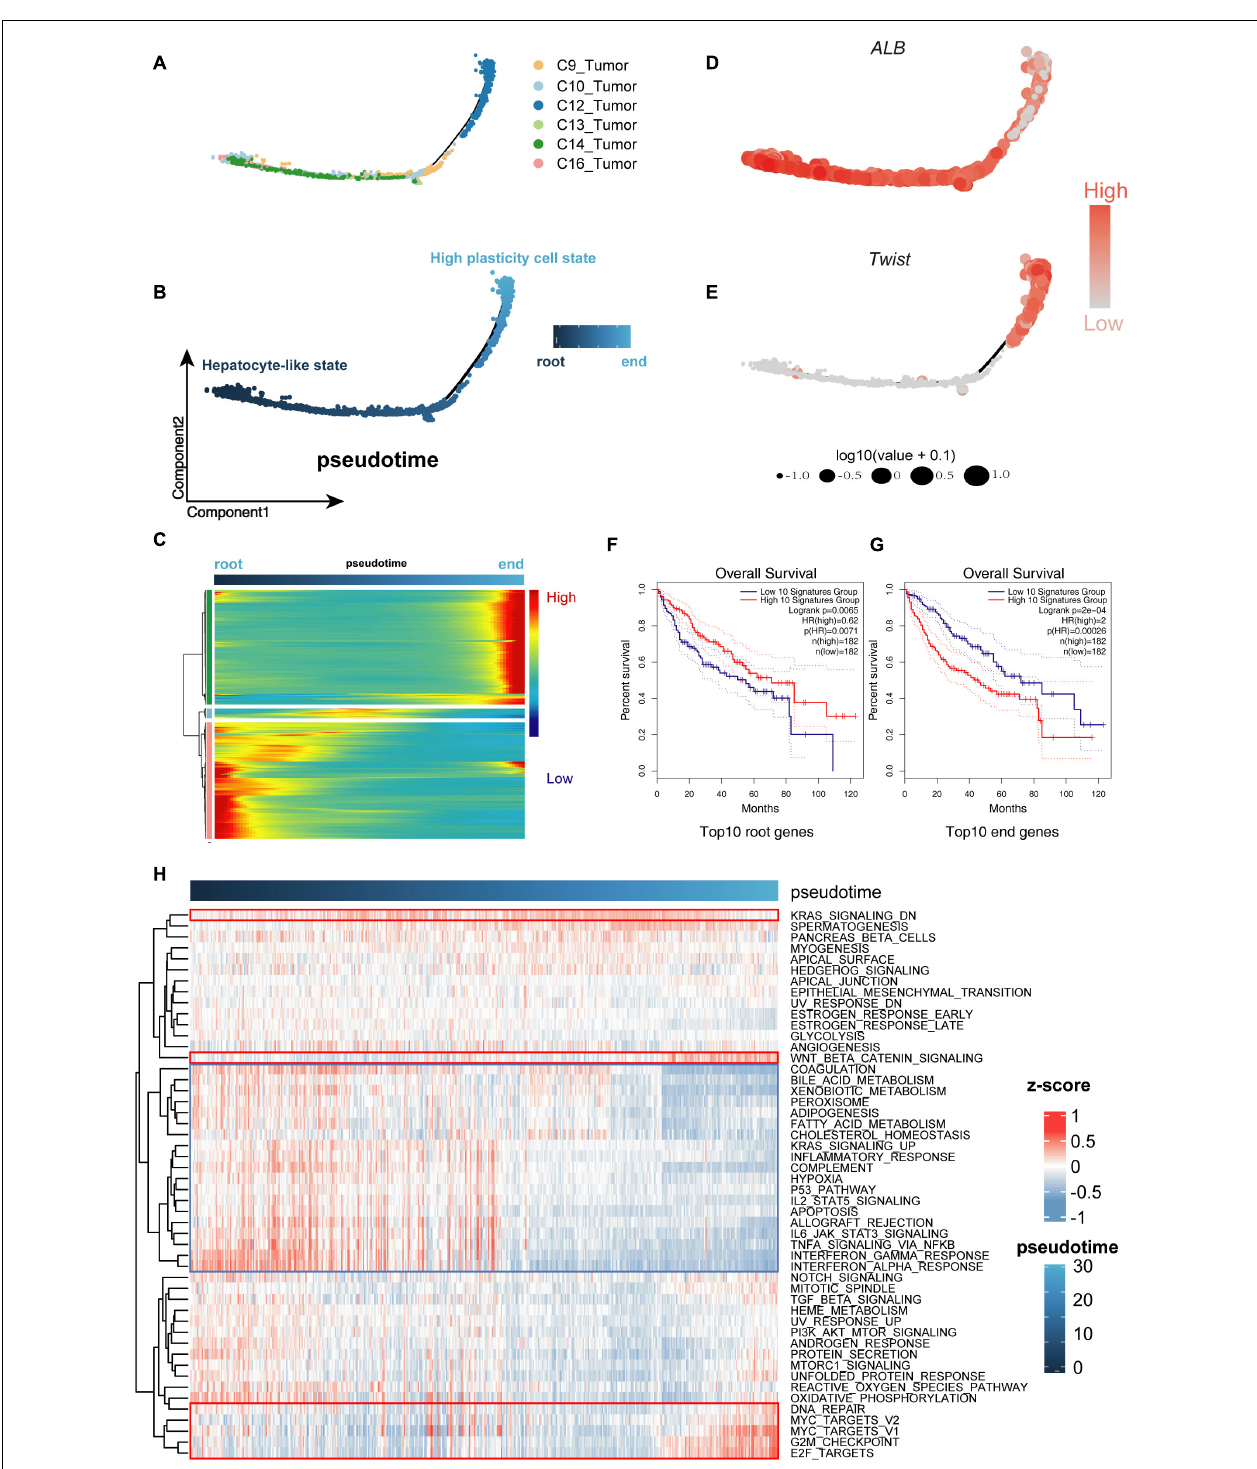
FIGURE 3 | Cells were sorted by progression from lower malignant state to higher malignant state. (A,B) Cell Trajectory performing the route of low- to high-malignant cells, which can serve as a model to describe malignant cell differences. (C) Expression levels for differentially expressed genes (rows), with cells (columns) shown in pseudo-time order. (D,E) ALB and Twist genes confirming the trusty of the cell progression trajectory model. (F,G) The Kaplan–Meier (K-M) analysis of the top 10 downregulated genes (root genes) and top 10 upregulated genes (end genes) from 1,000 differential genes group capturing the overall survival (OS) differences between low- and high-malignant cell groups. (H) Gene set variation analysis (GSVA) heat map showing the mainly differential signaling pathways between low- and high-malignant cell groups.